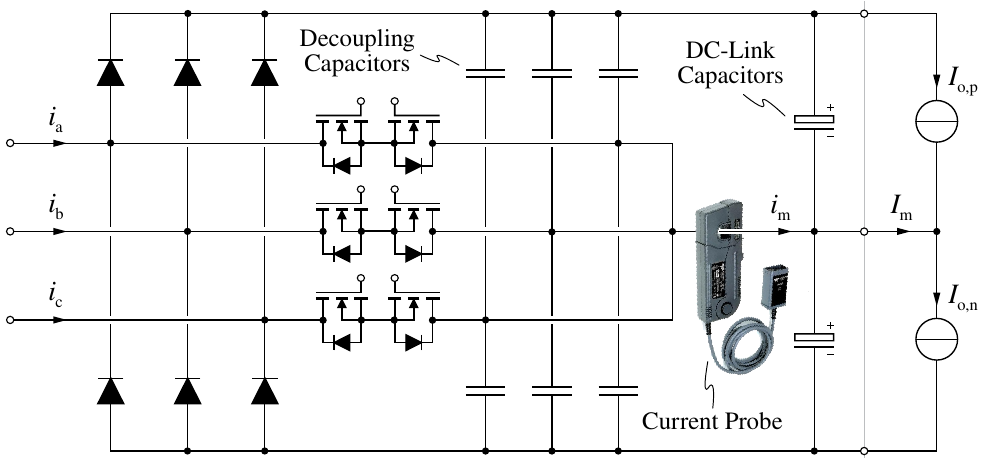
Figure 16. Schematic overview of the DC-link mid-point current i m measurement setup. The current probe is placed between the bridge-leg decoupling capacitors and the DC-link